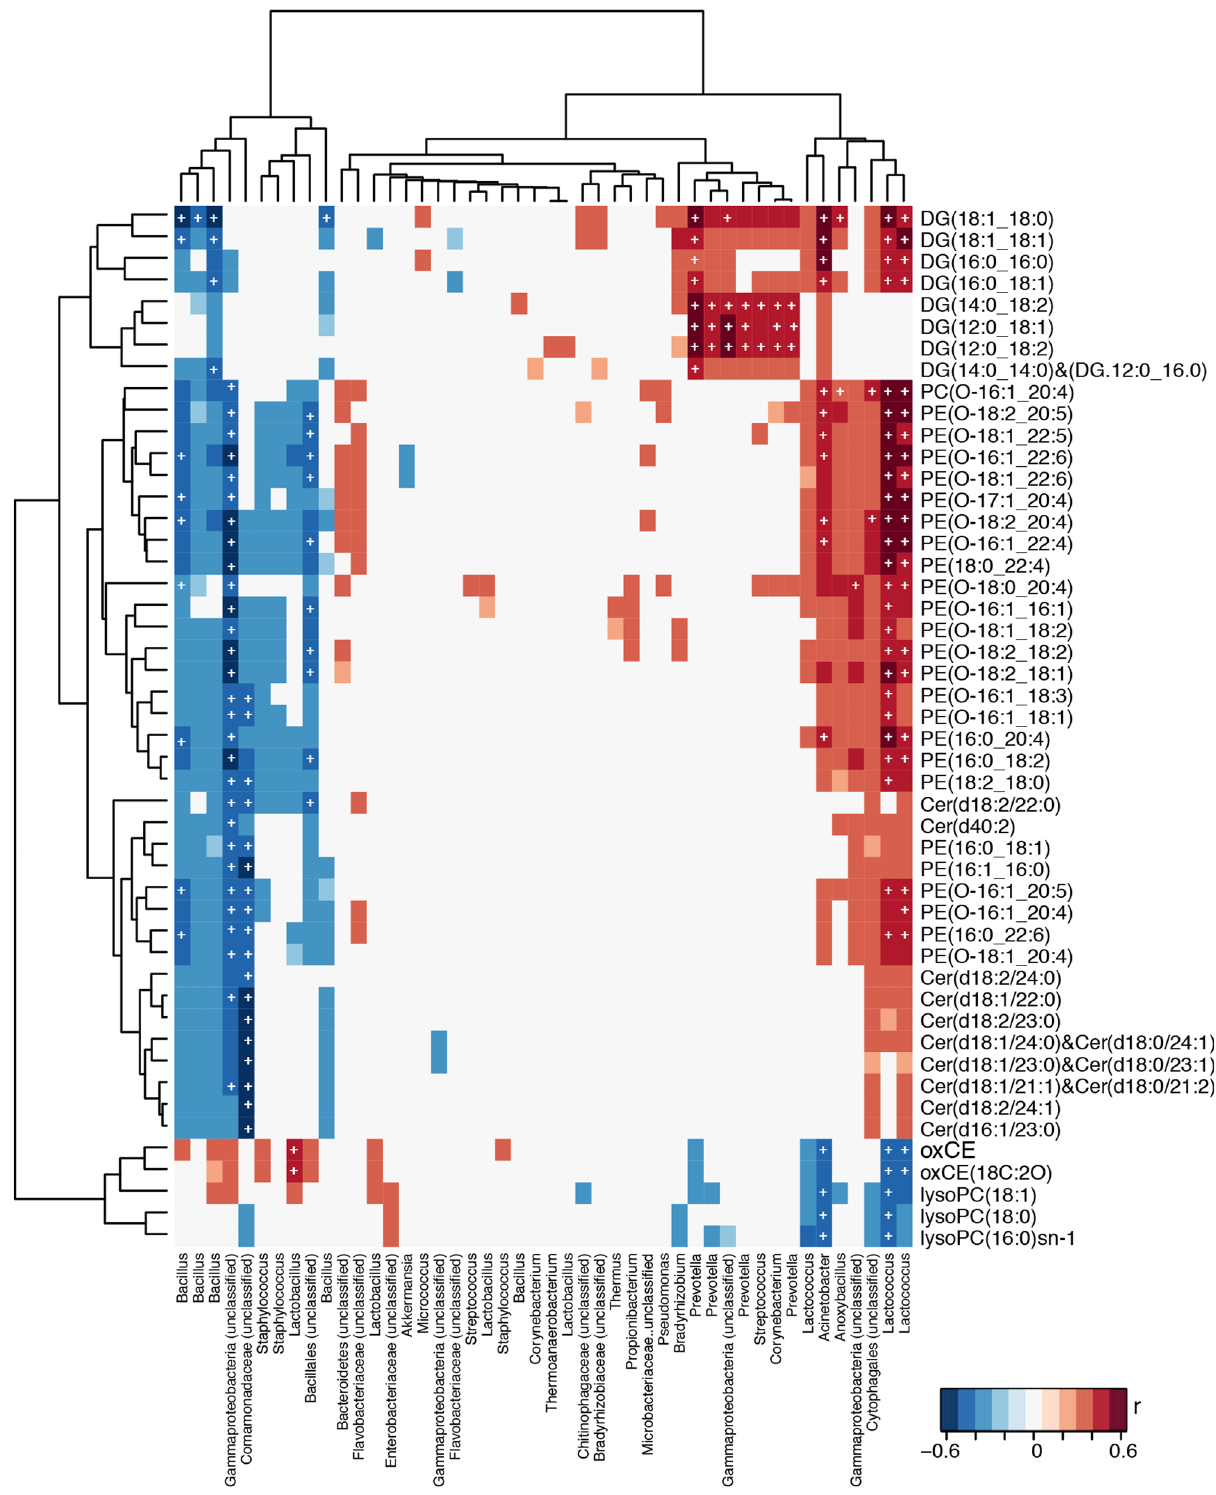
Fig. 3 Correlations between discriminant lipid and bacterial OTUs. Pearson ’ s correlation analysis identifying associations between lipids and bacterial OTUs in healthy-normal ( n = 16) and tumor-adjacent-normal tissues ( n = 32). Signi fi cant associations after FDR correction ( p < 0.05) are denoted with a white cross. Cer ceramide, DG diacylglycerol, lysoPC lysophosphatidylcholine, oxCE oxidized cholesteryl ester, PE